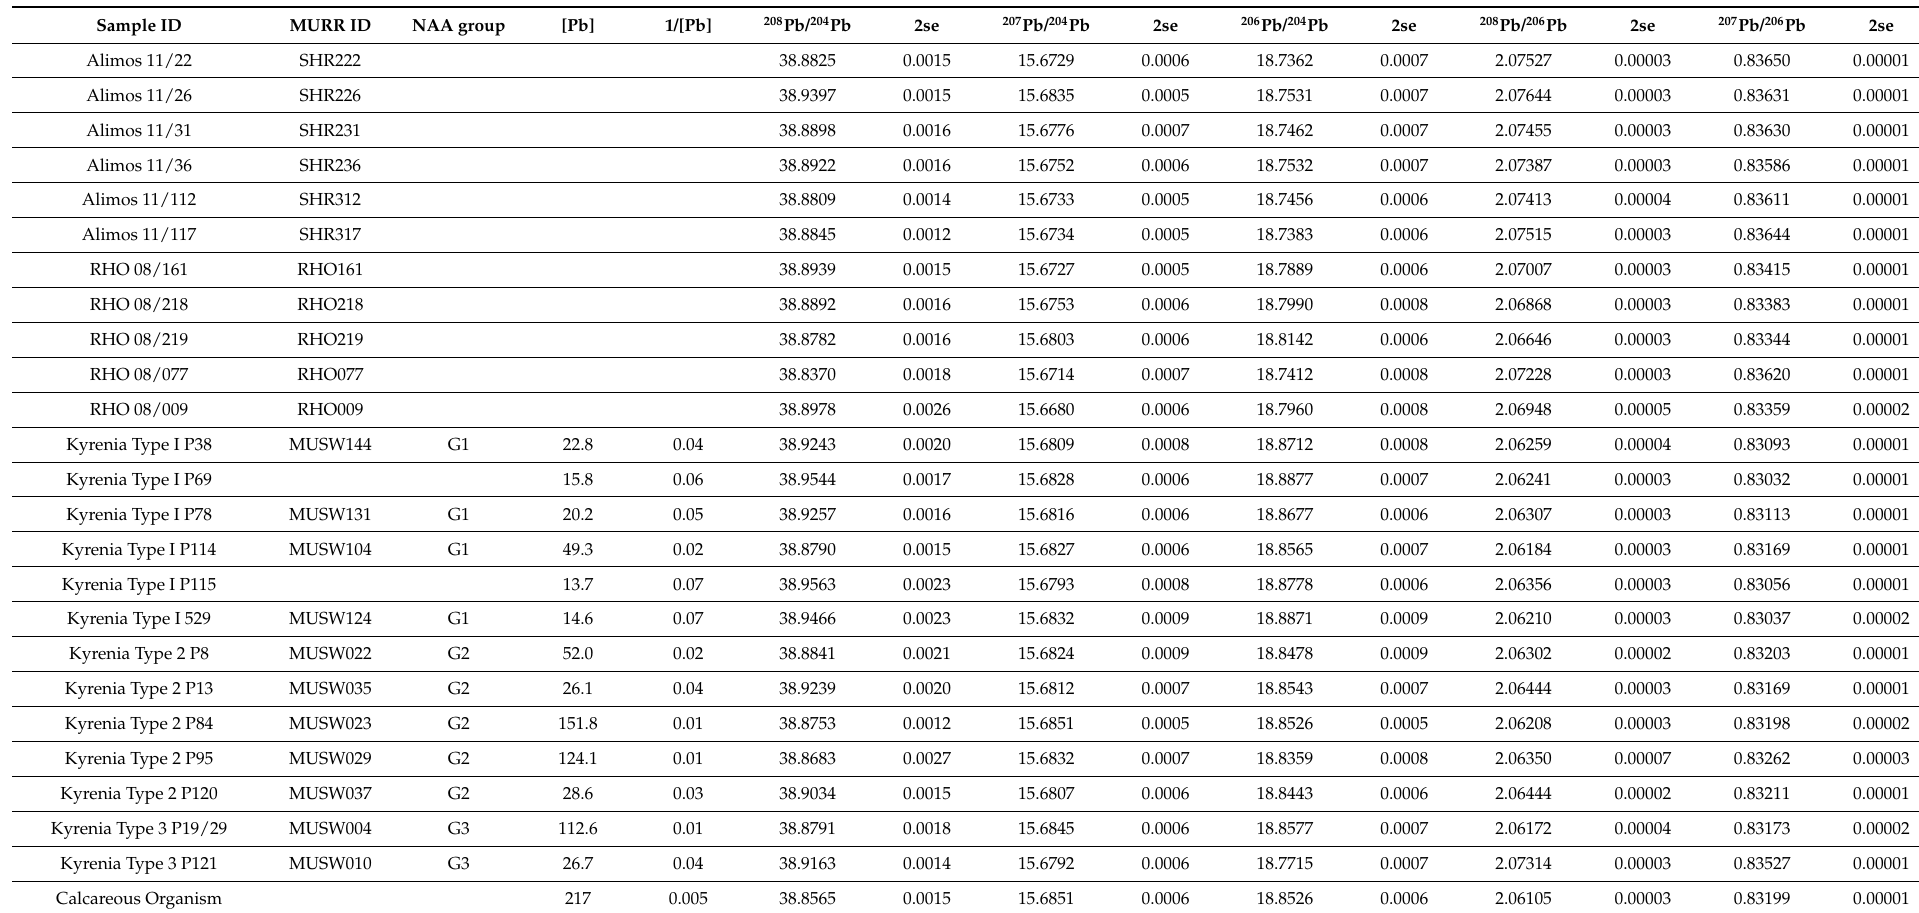
Table 1. Sample ID; MURR ID; chemical group identified by NAA for the Kyrenia ceramic samples with G1 for the NAA group 1 (assigned to Rhodes), G2 for the NAA group 2 (assigned to Alimos, Athens, or Rhodes), and G3 for the NAA group 3 (assigned to Athens) [7]; lead concentration ( µ g g − 1 ); lead isotopic ratios; se for standard error (internal error). * for replicates (i.e., second analysis of the same solution on the MC–ICP–MS), ** for duplicates (i.e., entire procedure applied twice to the same